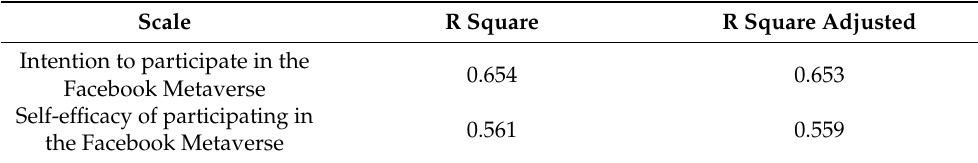
Table 3. R Square and R Square Adjusted.